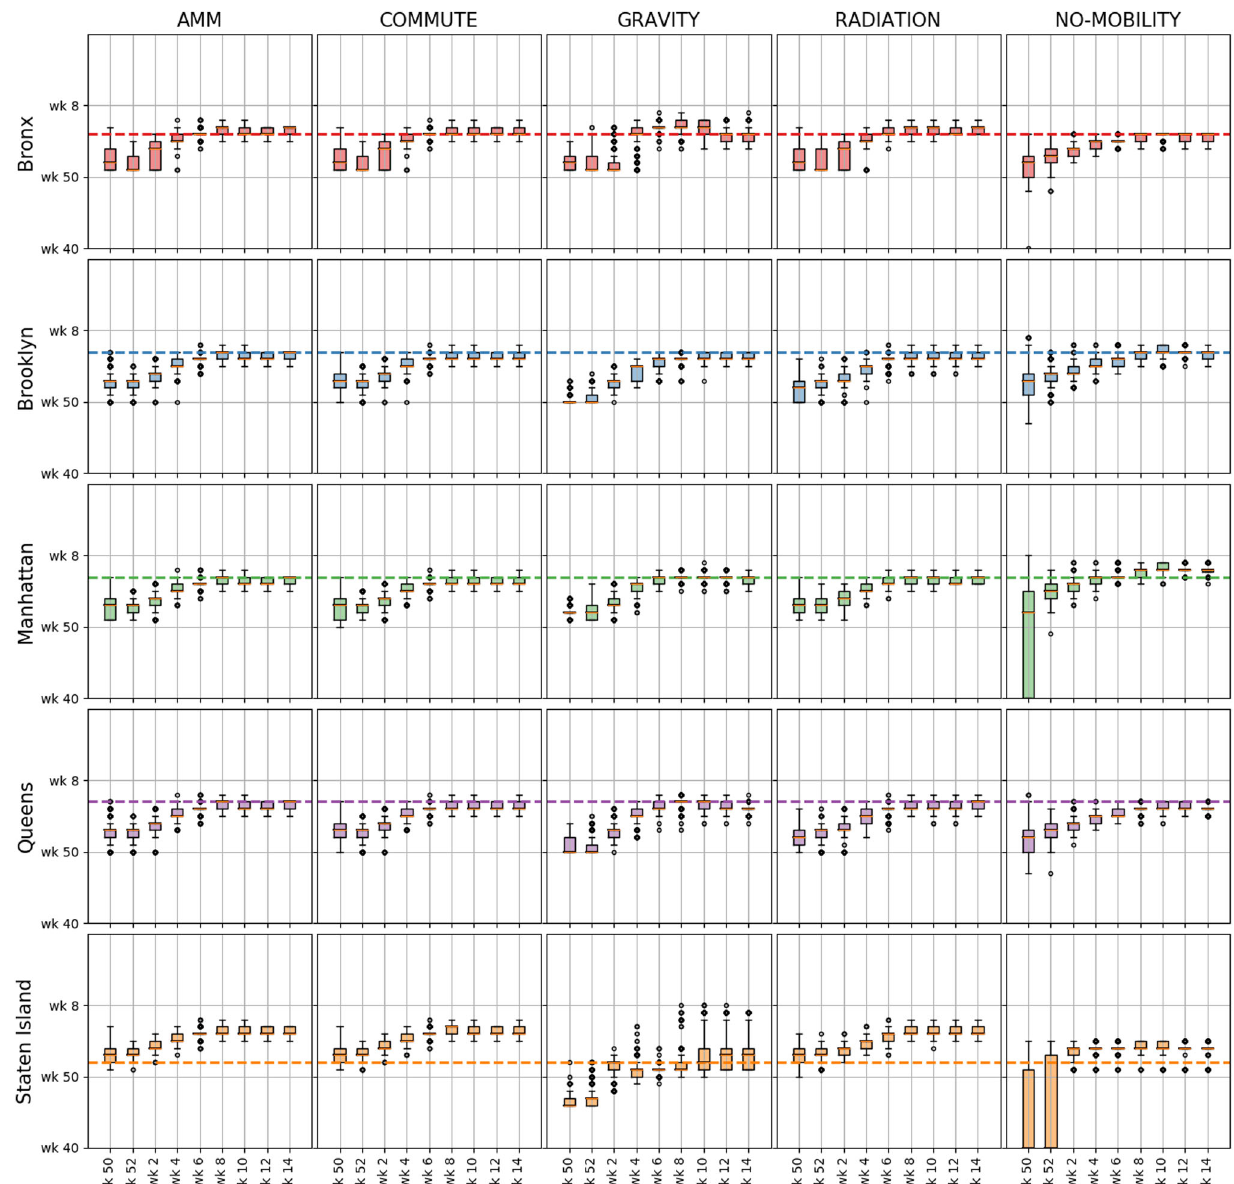
Fig. 5 Multi-horizon comparison of seasonal forecasts across networks. For each of the networks (columns), and each borough (rows), the boxplots (median, IQR, and whiskers at 1.5 IQR) show the posterior predictive distribution for peak time forecast at different time horizons ( n = 1000). Similar plots for other targets (peak value, onset time) and other seasons are available in Supplementary Notes